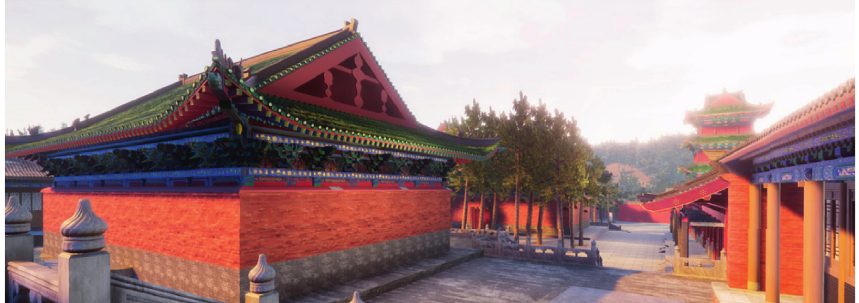
Figure 15: Schematic diagram of the digital restoration of the “Shaolin Temple” building applying the virtual reality approach of this